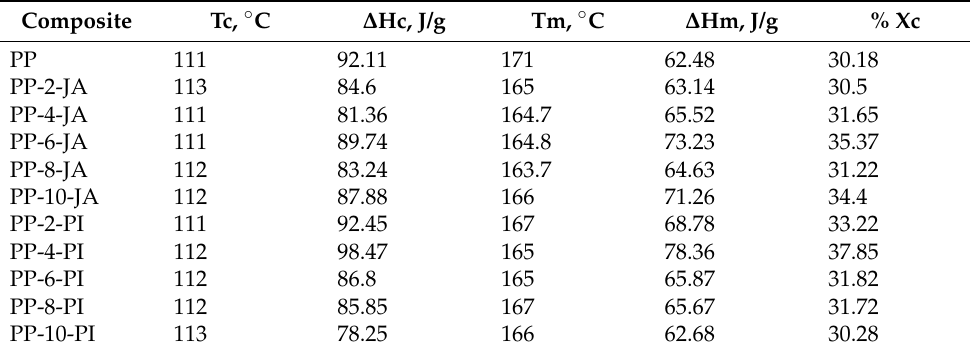
Table 2. Thermal data obtained by DSC for PP, PP-JCSP and PP-PSP